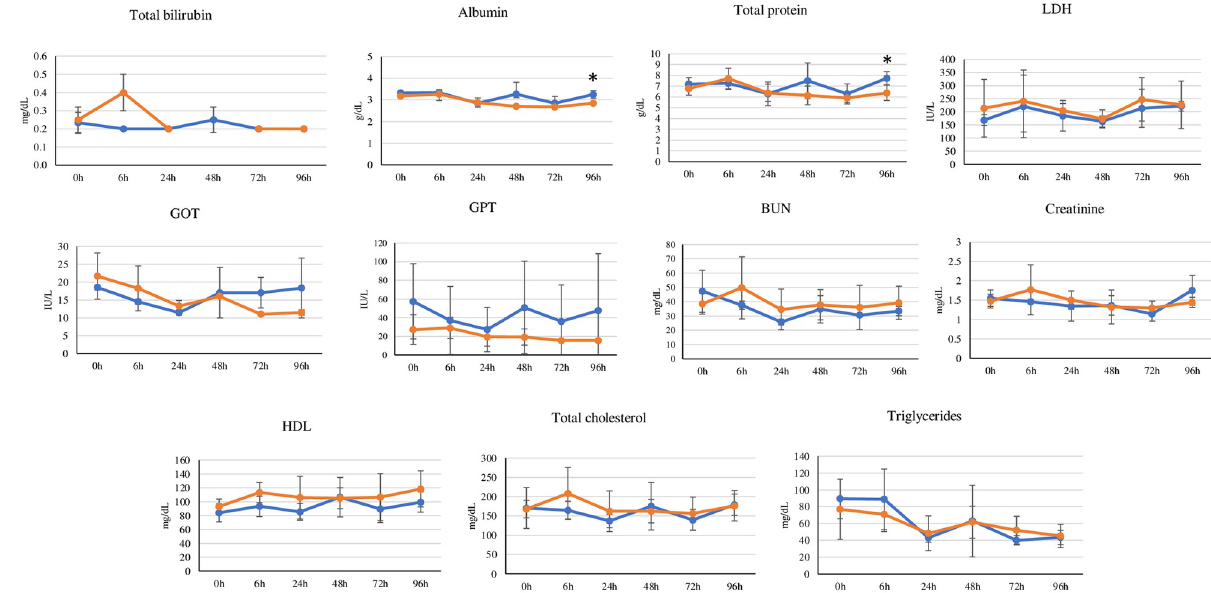
Fig 2. Time courses of the serum biochemical changes (mean ± SD) in time courses of the control (blue) and PCB treatment (orange) groups ( � : Significant differences between two groups, P < 0.05).